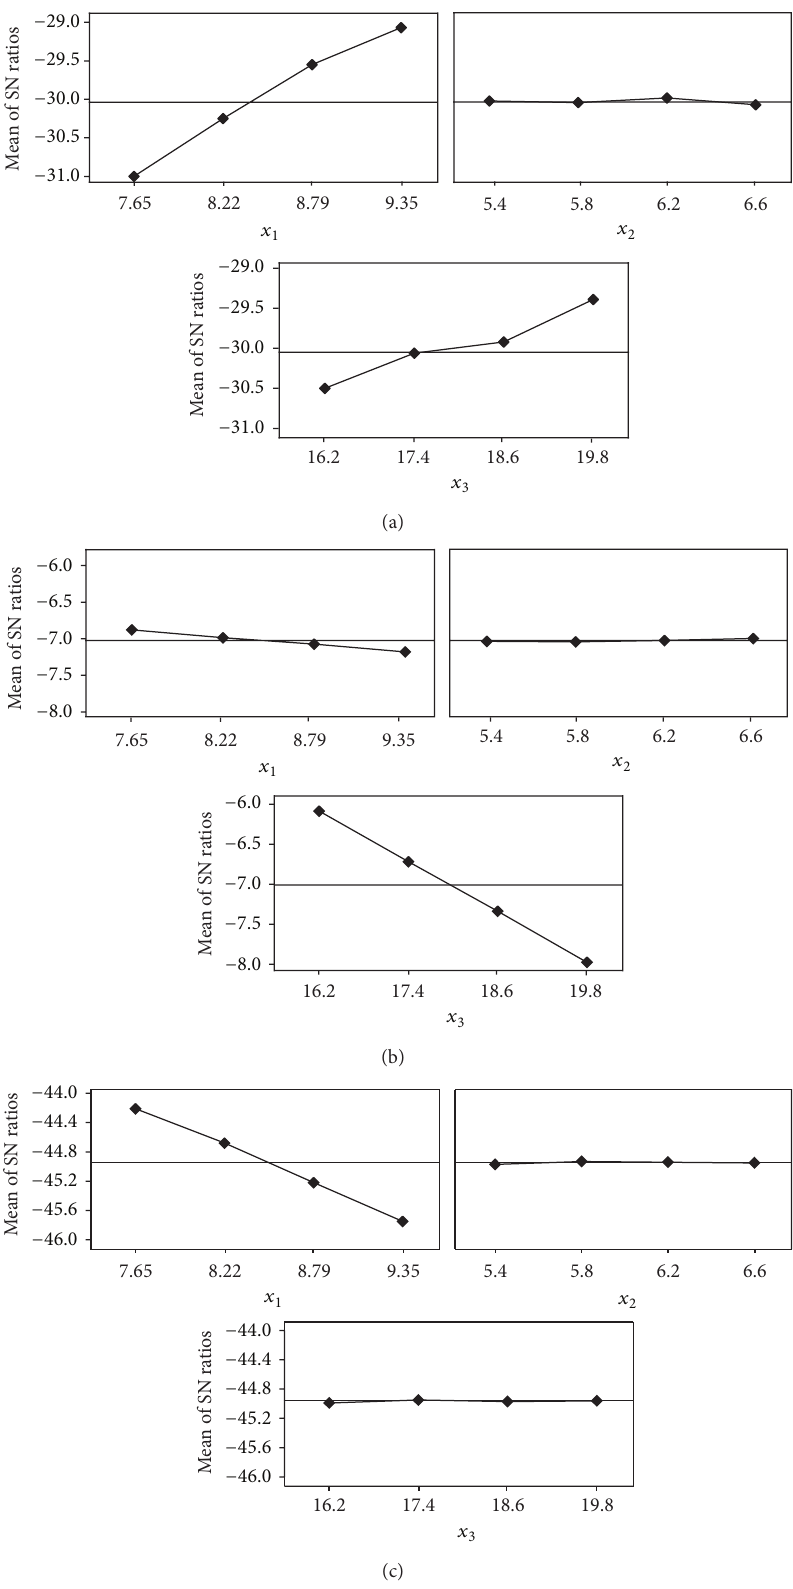
Figure 5: Plots to represent the main effects of the design variables on (a) pressure drop, (b) maximum stress, and (c)